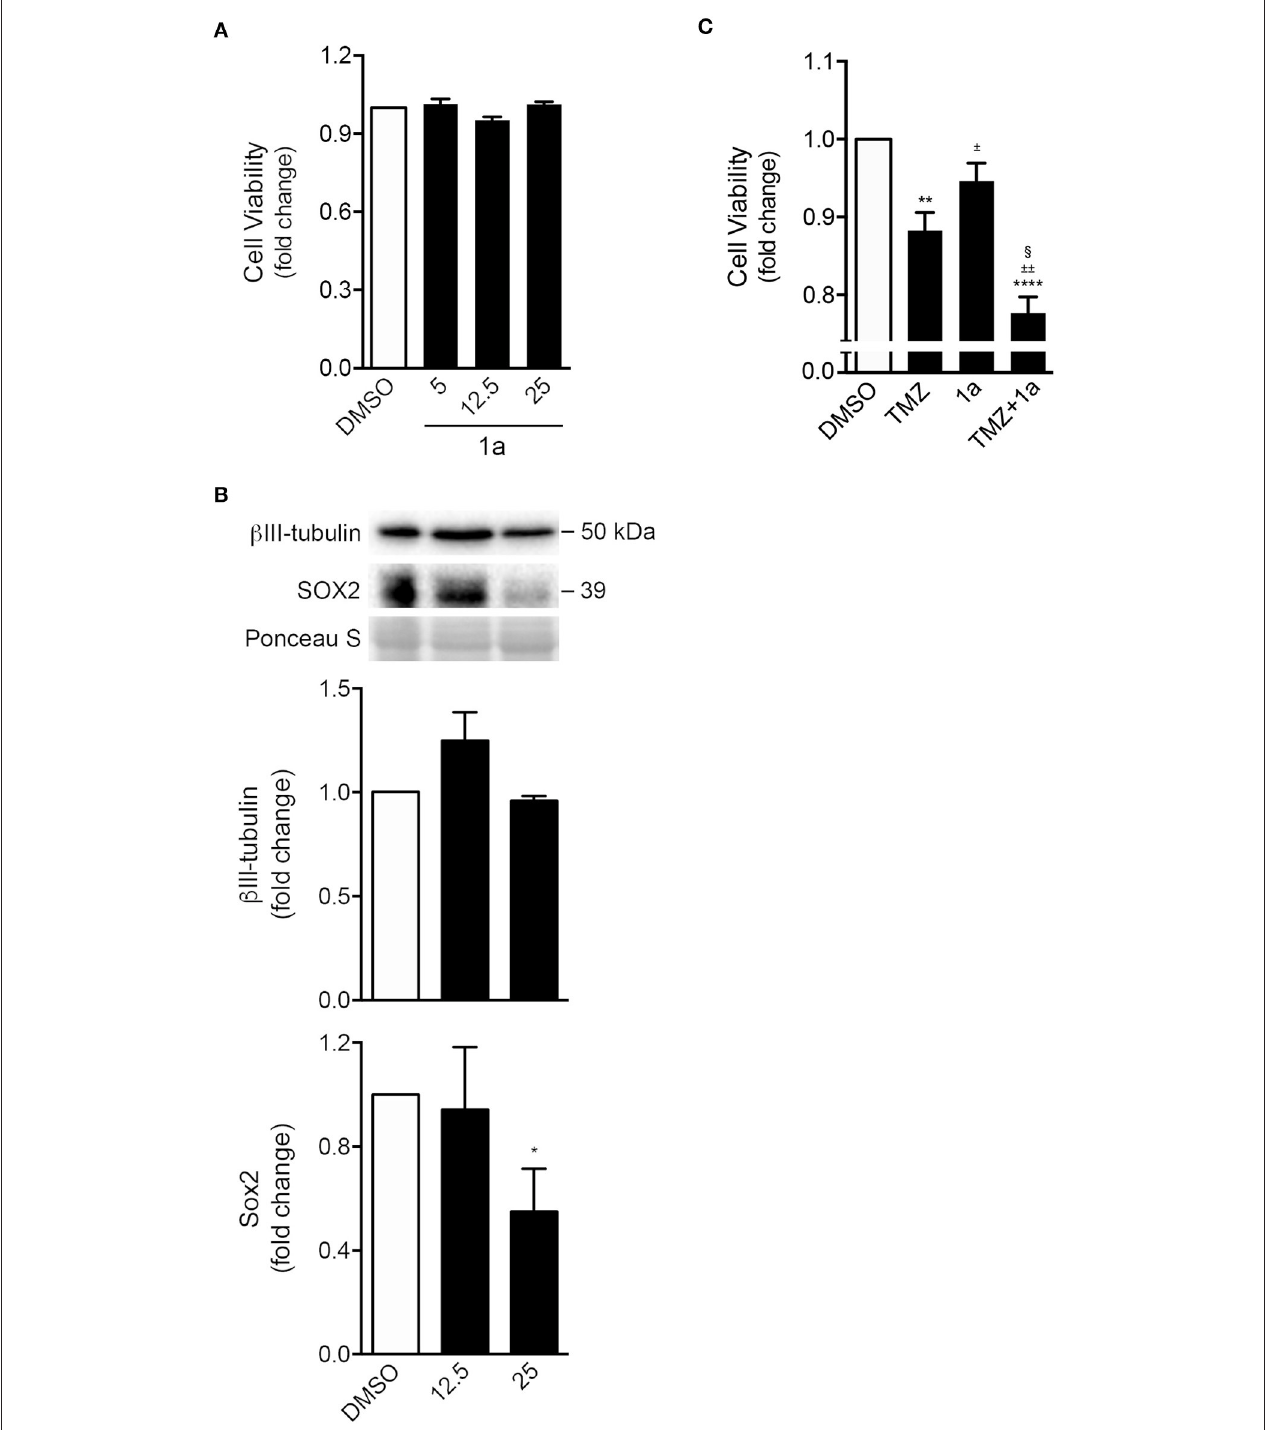
FIGURE 6 | Spiropyrazoline oxindole 1a reduces stemness of GL-261 mouse glioma cells while sensitizes conventional chemotherapeutic-induced cell death. GL-261 cells were treated with compound 1a or DMSO (control) for 24h and collected for MTS and Western blot analysis. (A) Cell viability as analyzed by MTS metabolism in GL-261 cells treated with 5, 12.5, or 25 µ M of compound 1a . (B) Representative immunoblots (top) and corresponding densitometry analysis (bottom) of Sox2 and β -III tubulin protein levels after 24h of 12.5 or 25 µ M of 1a treatment. Ponceau staining was used as loading control. (C) Cell viability as analyzed by MTS metabolism in GL-261 cells co-treated with 1a (12.5 µ M) and the chemotherapeutic agent TMZ (400 µ M) for 24h. Data represent mean ± SEM of at least three independent experiments. * p < 0.05, ** p < 0.005, and **** p < 0.0001 from DMSO; ± p < 0.01 and § p < 0.0001 from TMZ-treated cells; ±± p < 0.0001 from 1a -treated cells by one-way ANOVA followed by Tukey’s multiple comparison test. TMZ, temozolomide.